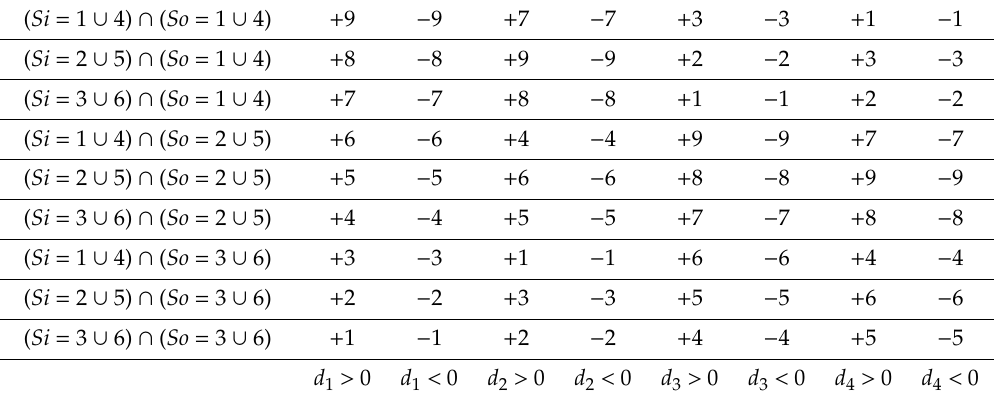
Table 3. List of active switch (vectors) configurations assigned to of individual So and Si for appropriate d 1 –d 4